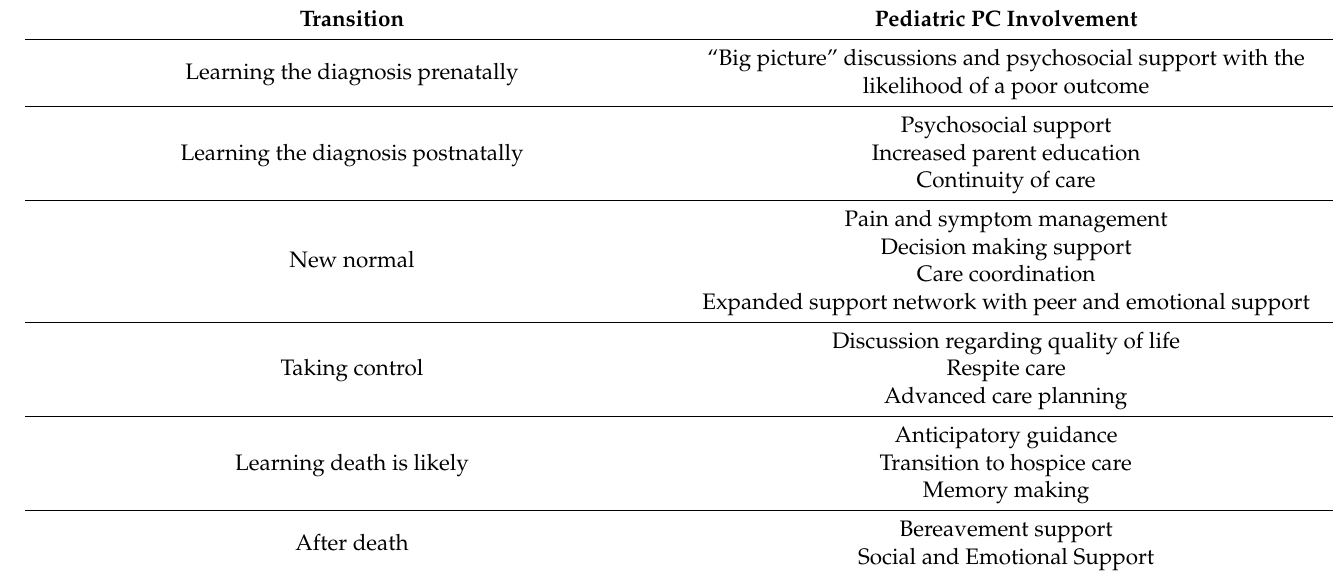
Table 1. Common psychological, emotional, and cognitive transitions in families after a life-limiting pediatric cardiac diagnosis and targeted goals for pediatric PC involvement *.